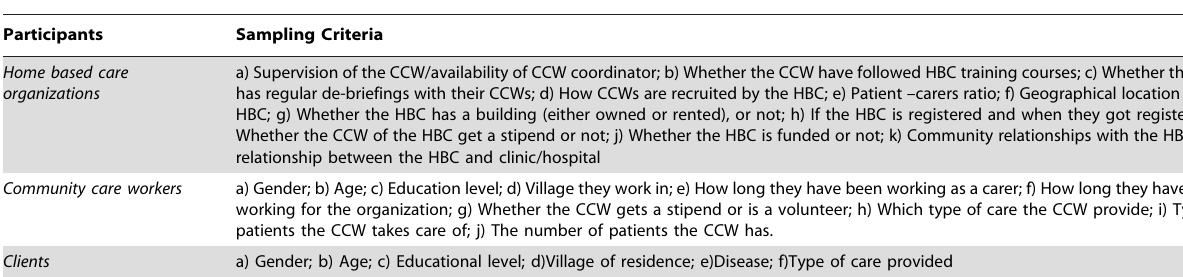
Table 1. Criteria used for sampling of HBC organizations, CCWs, clients and their PCGs.